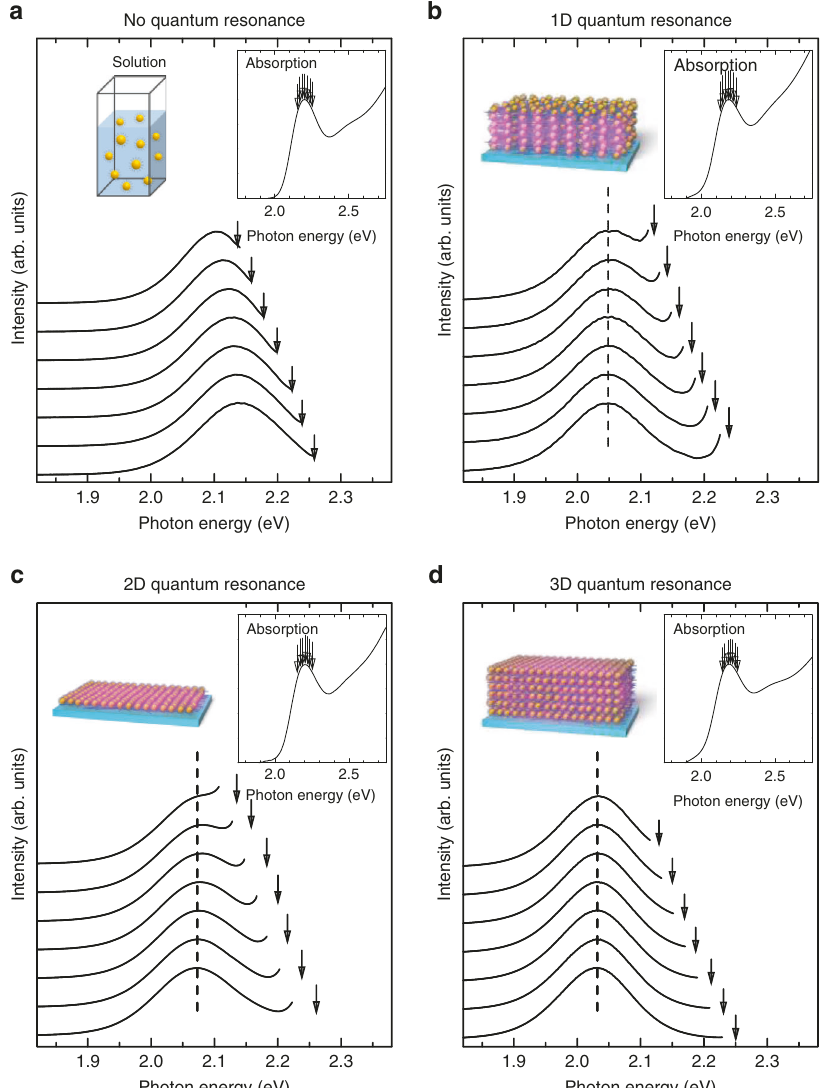
Fig. 6 Excitation energy dependence of the photoluminescence spectra. a – d Excitation energy dependence of the photoluminescence spectra of CdTe quantum dot solution in which quantum dots are randomly dispersed a , and CdTe quantum dot superlattices exhibiting 1D b , 2D c , and 3D d quantum resonances. The solid lines show photoluminescence spectra with different excitation energies. The excitation energy increases from top to bottom. The insets show the absorption spectra of each sample. The down arrows indicate the excitation energies in the photoluminescence measurements. The dashed lines show the peak value of the photoluminescence